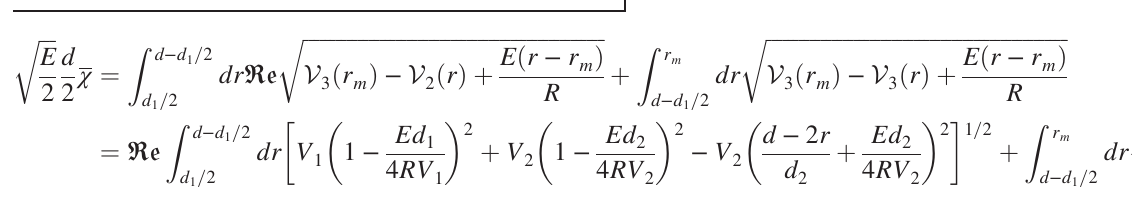
dr ffiffiffiffiffiffiffiffiffiffiffiffiffiffiffiffiffiffiffiffiffiffiffiffiffiffi r ffiffiffiffiffiffiffiffiffiffiffiffiffiffiffiffiffiffiffiffiffiffiffiffiffiffi ;